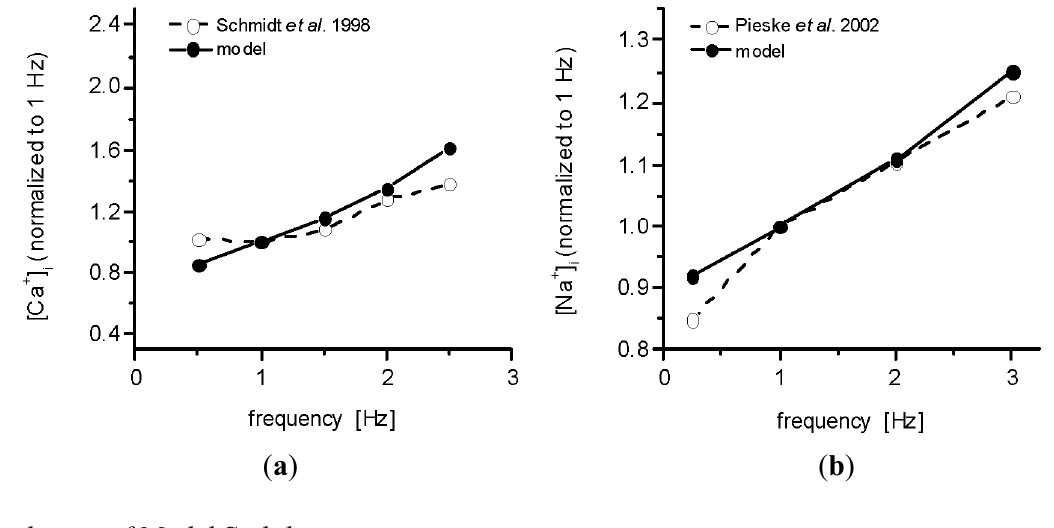
Figure 9. Comparison of normalized data showing the frequency-dependent increase of intracellular diastolic ion concentrations in the present model and in the experimental studies. ( a ) [Ca 2+ ] (100 APs elicited at each stimulation rate); data published by i Schmidt et al. [27]; and ( b ) [Na 2+ ] (600 APs elicited at each stimulation rate); i data published by Pieske et al.